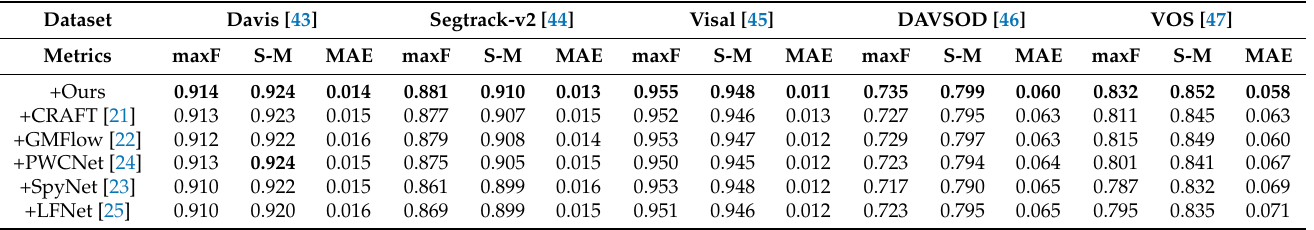
Table 5. Comparison of performance for fine-tuning LIMS model with different optical flow models, “+” represents fine-tuning the LIMS model using different optical flow models, and “Ours” represents our optical flow model, with the best metrics shown in bold.